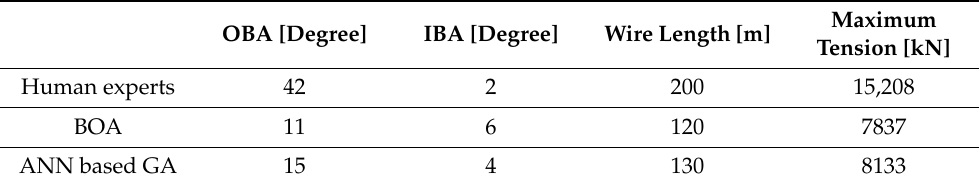
Table 9. Maximum tension and design variables of each mooring